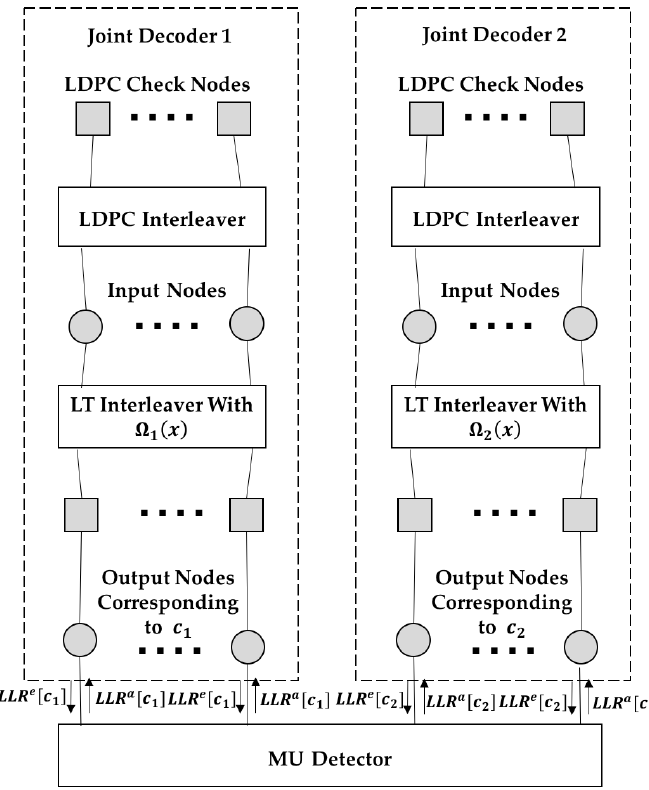
Figure 2. Decoding graph at the baseband unit (BBU) pool.